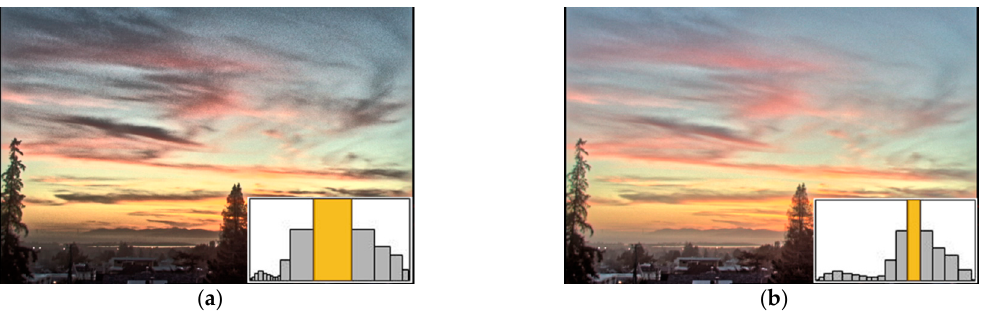
Figure 6. Self-evaluation of the proposed HVS-based modified histogram equalization. ( a ) Result and the histogram before correction, whose bin width is calculated by Equation (15). ( b ) Result and the histogram after correction, whose bin width is calculated by Equation (18). The histograms of ( a ) are too wide so that the resulting image is slightly noisy in the sky.